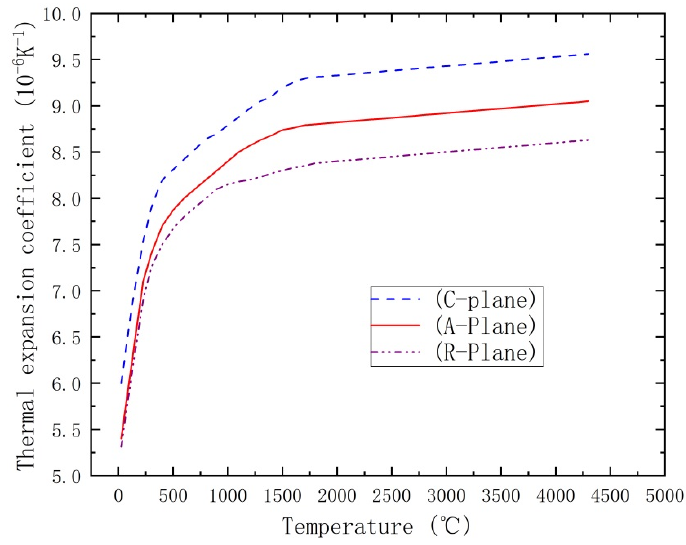
Figure 5. Thermal expansion coefficient varies with temperature of sapphire crystal.